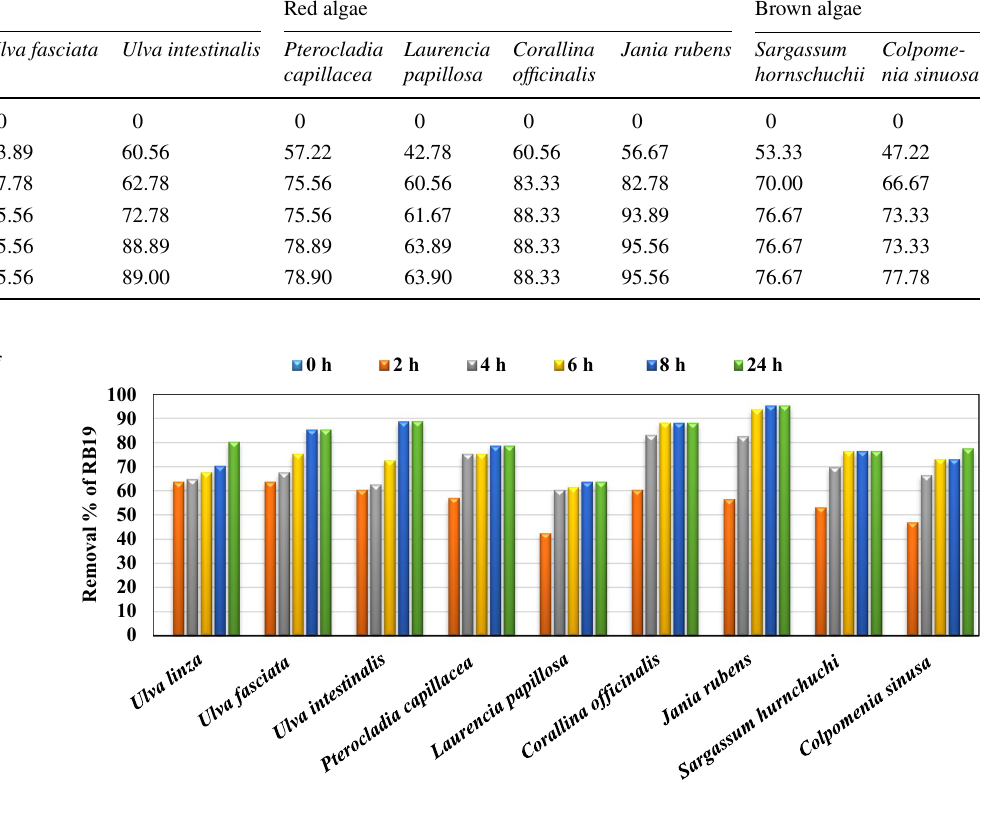
Table 2 Removal percentage of Reactive Black 5 (RB5) by the nine studied fresh algal species Removal % of RB5 (λmax = 595 nm)